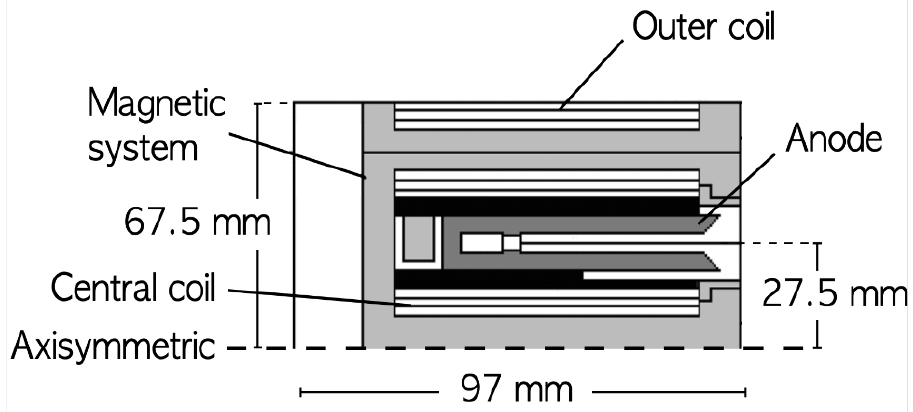
Figure 2. Configuration of the D55 Hall thruster.